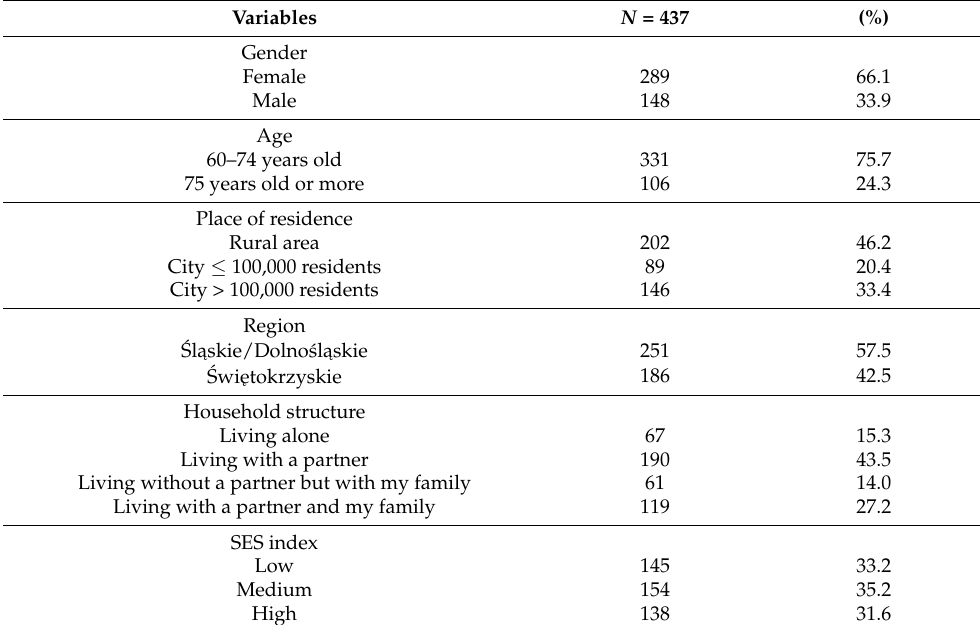
Table 1. Study sample